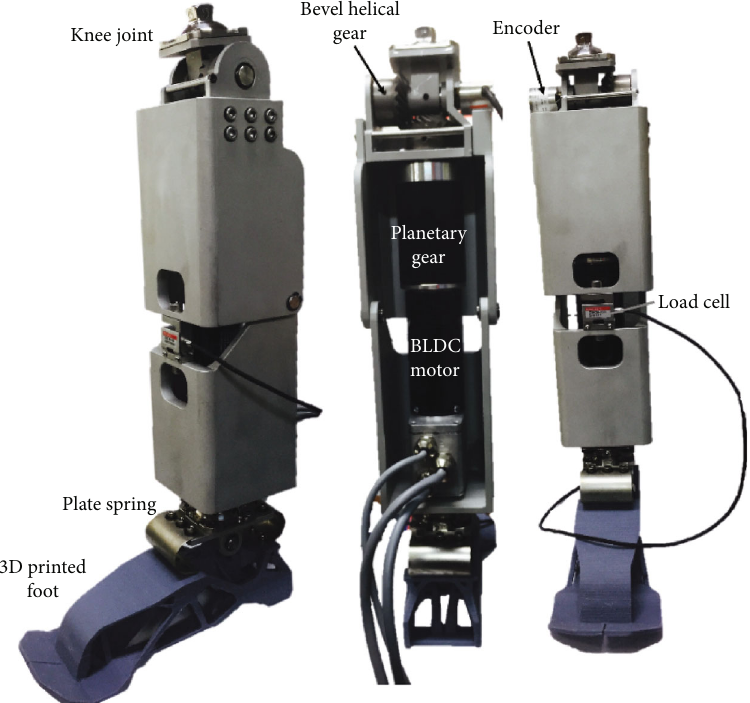
Figure 8: Developed active prosthetic leg